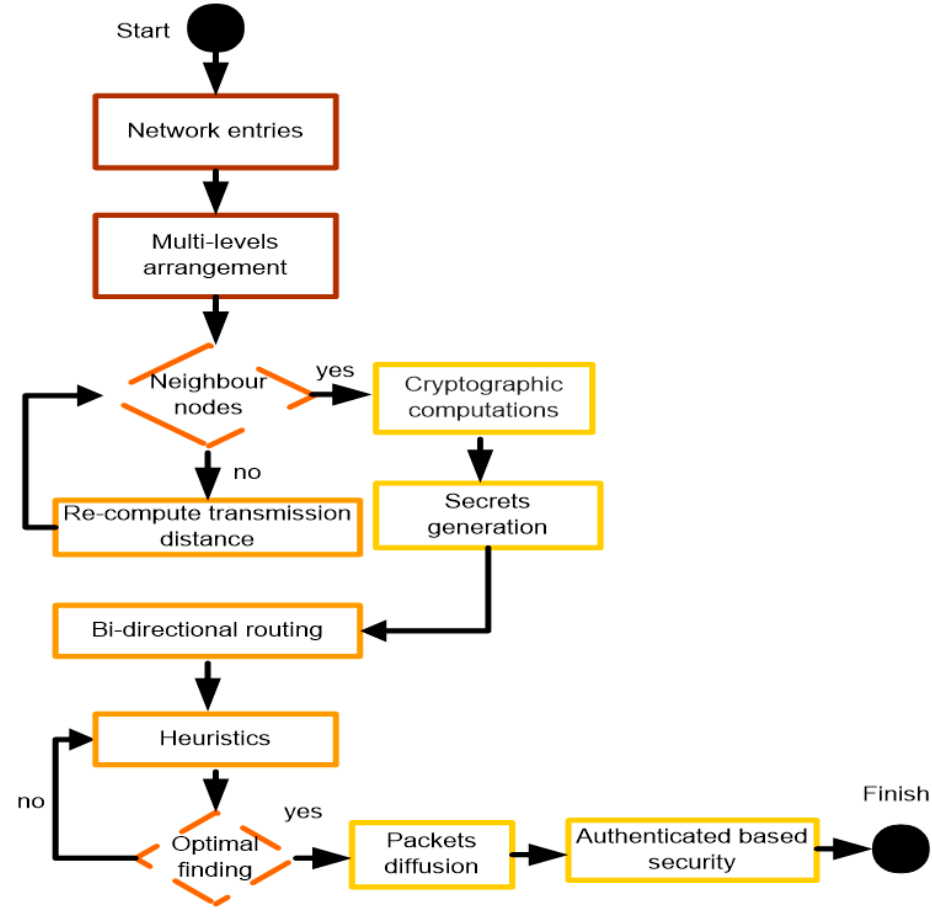
Figure 2. Procedural diagram of the proposed approach.